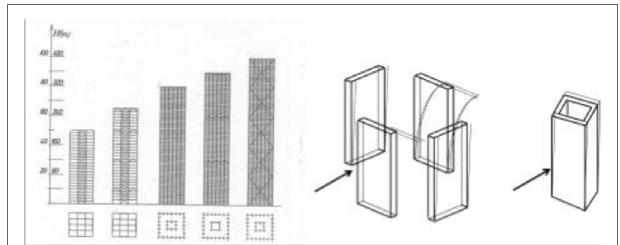
FigURe 4 | On the left: structural systems for tall buildings [adapted from Pozzati and Ceccoli (1980)]. On the right: wall versus tube behavior [adapted from Khan